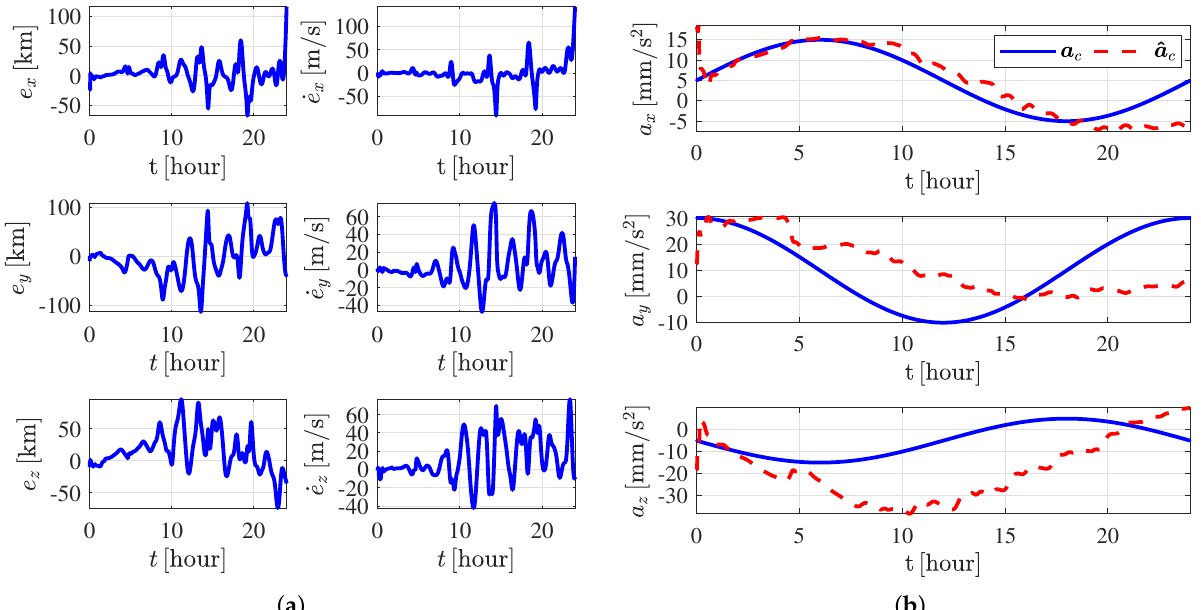
Figure 8. OD results using the first-order polynomials. ( a ) State estimated errors. ( b ) Maneuver estimated comparison (the blue lines denote the real maneuvering acceleration and the red dashed lines represent the estimated maneuvering